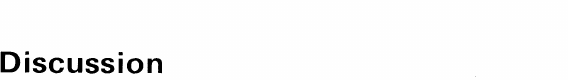
"’..:i;iiiiiii!i!ii::..i!.i.